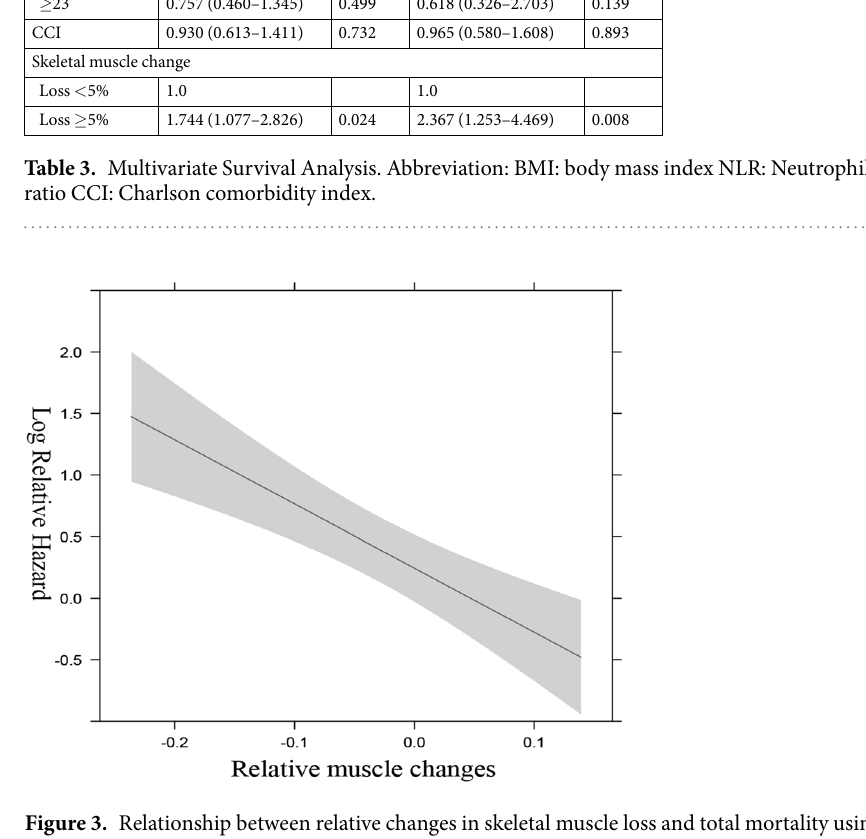
Figure 3. Relationship between relative changes in skeletal muscle loss and total mortality using restricted cubic